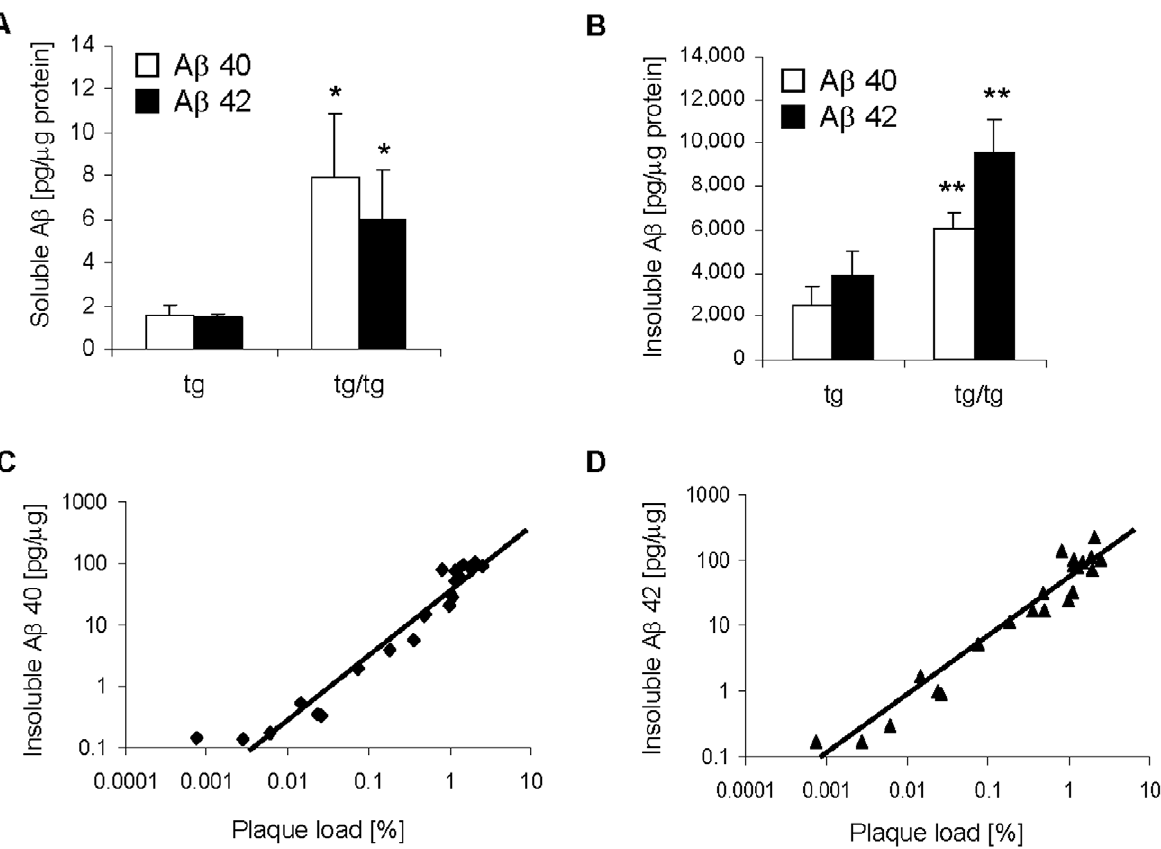
Figure 3. Correlation between insoluble A b and plaque burden. A, B , Quantification of A b peptides in brain extracts from hemizygous and homozygous ARTE10 mice. 12 months old mice from the cross sectional study were used for the analysis. Soluble (A) and insoluble A b (B) was extracted with Tris buffer and formic acid, respectively, and the amount of A b 40 (open bars) and A b 42 (filled bars) was quantified. The brains of homozygous mice contained more soluble as well as insoluble A b in comparison to hemizygous mice. Data are expressed as means + SEM. Tg, hemizygous transgenic mice; tg/tg, homozygous transgenic mice. * p , 0.05, ** p , 0.01, tg versus tg/tg at the respective age (unpaired t-test). C, D , Correlation of insoluble A b and plaque load calculated by Acapella TM software. Insoluble A b 40 (C) and A b 42 (D) were extracted from one brain hemisphere of hemizygous ARTE10 mice of different age (4 to 15 months old). Plaque load was calculated by Acapella TM image analysis software from sections of the corresponding second hemisphere after staining against b -amyloid. A strong correlation between plaque burden and insoluble A b was found. C, R 2 =0.86; D, R 2 =0.69.